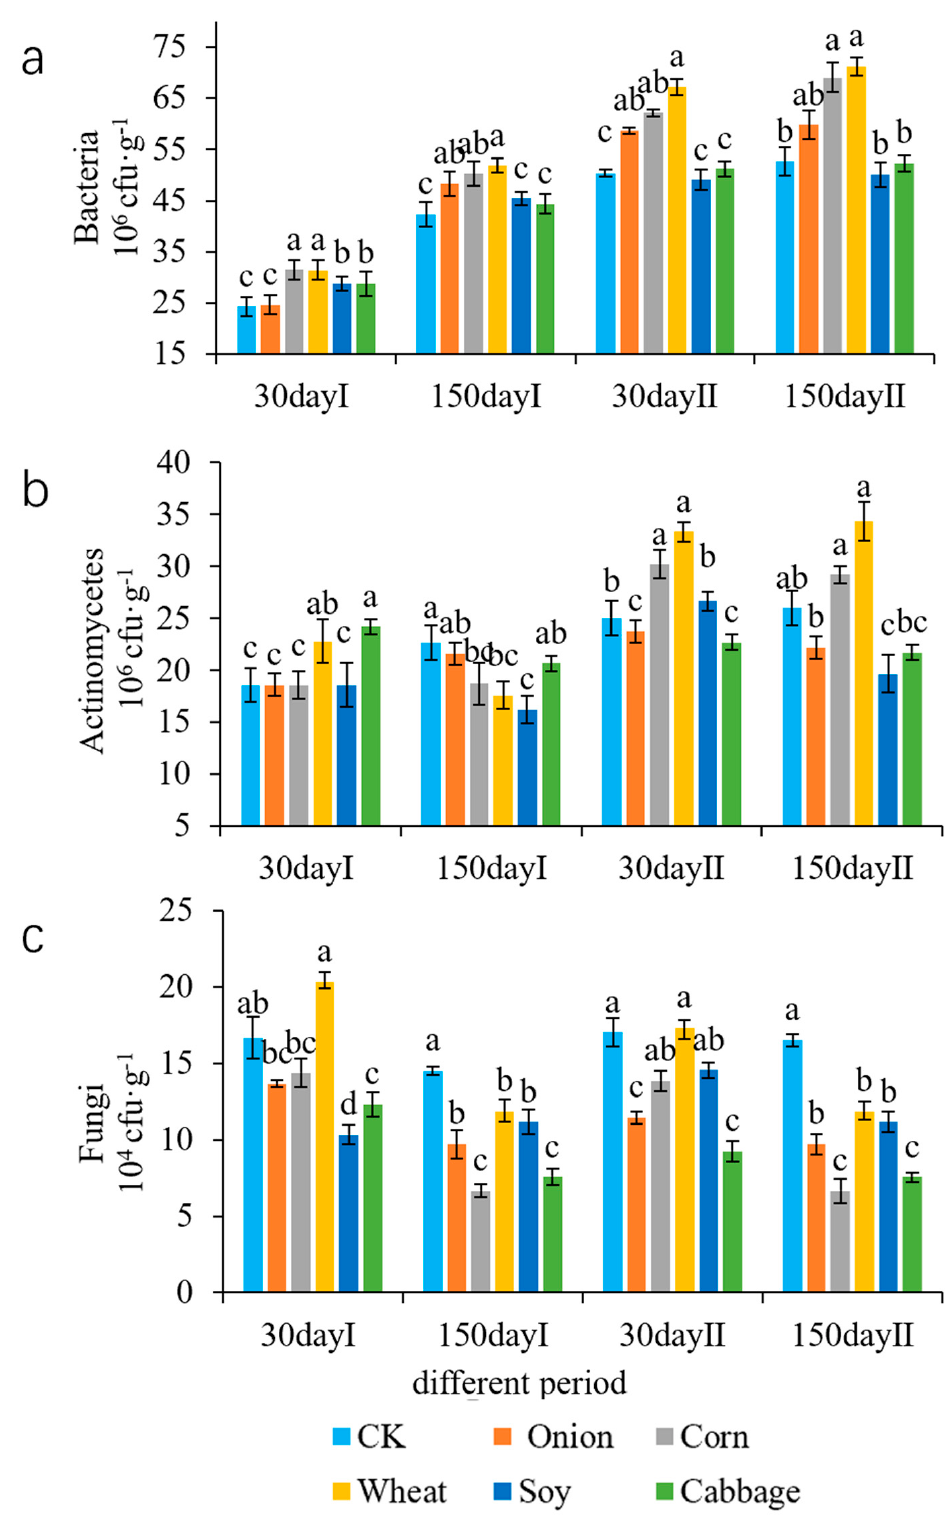
Figure 3. Effects of different catch crops on amounts of soil cultivable bacteria, actinomycetes and fungi. Bacteria ( a ), Actinomycetes ( b ), Fungi ( c ). Different small letters represent significant difference at 0.05 level by Duncan’s test.